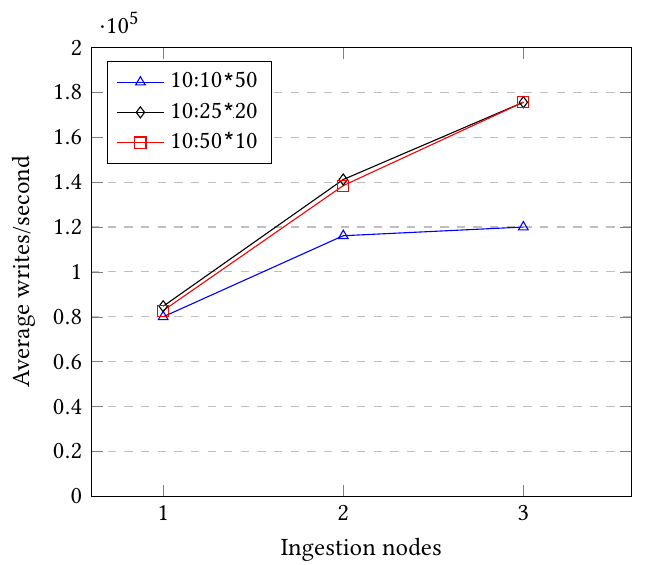
Figure 17. Performance of the different setups for a column length of 10 time steps. Figure 4: Scalability of the proposed approach with one to three ingestion nodes, for set ups of 10 as column length.